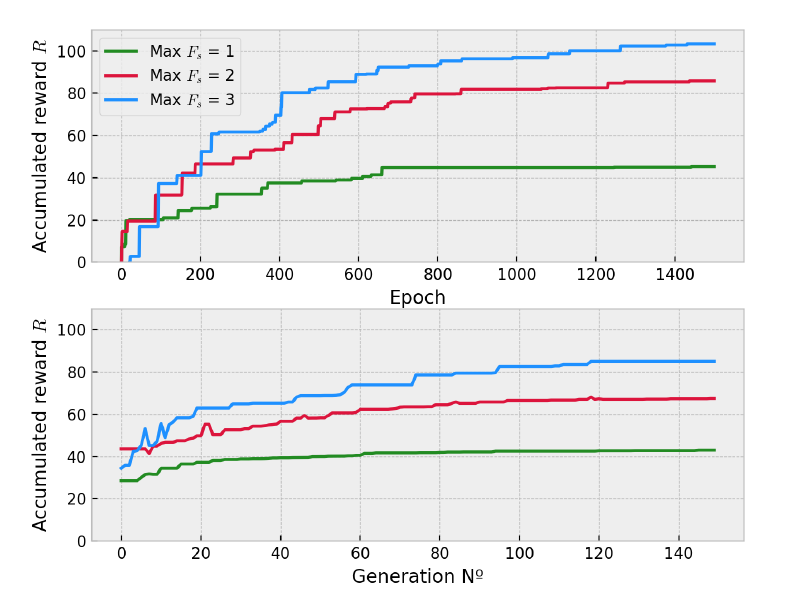
Figure 19. Training progression of the max. AER in the multi-agent case for DDQL ( up ) and EA ( down ) for 1500 episodes and a max. value of generations of 150